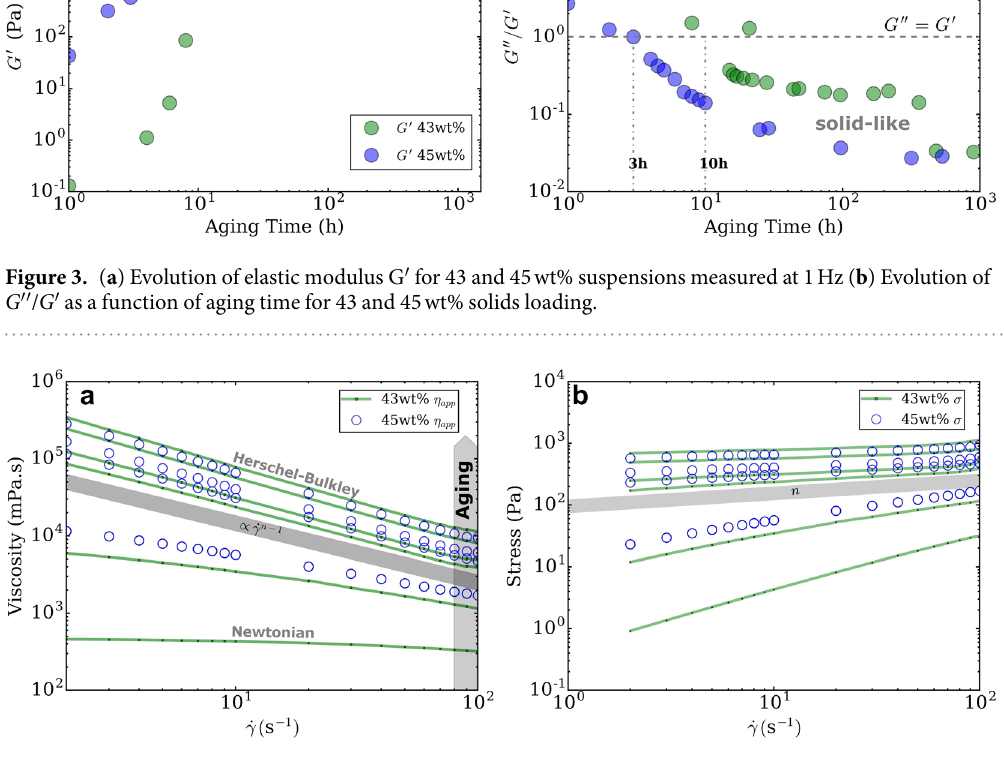
Figure 4. Evolution of viscosity η app ( a ) and stress σ ( b ) as a function of shear rate γ  for 43 and 45 wt% suspension at respectively t aging = 0, 6, 16, 21, 44, 96 h and t aging = 0, 5, 8, 25 h , from bottom to top for both